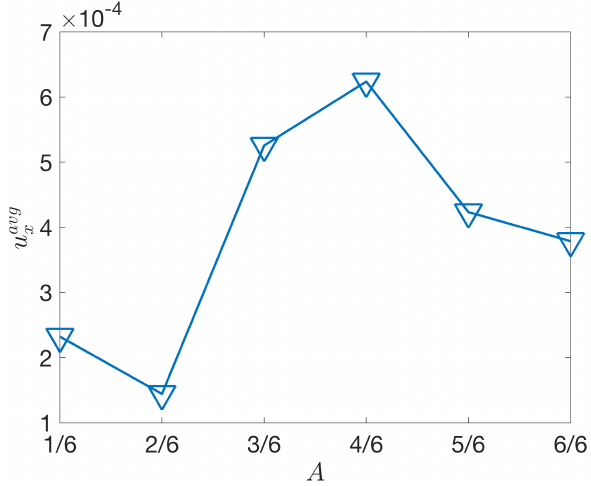
Figure 5. Average flow speeds in a 2 L × 2 L region in the wake of the tail plotted with respect to the activation region, A .